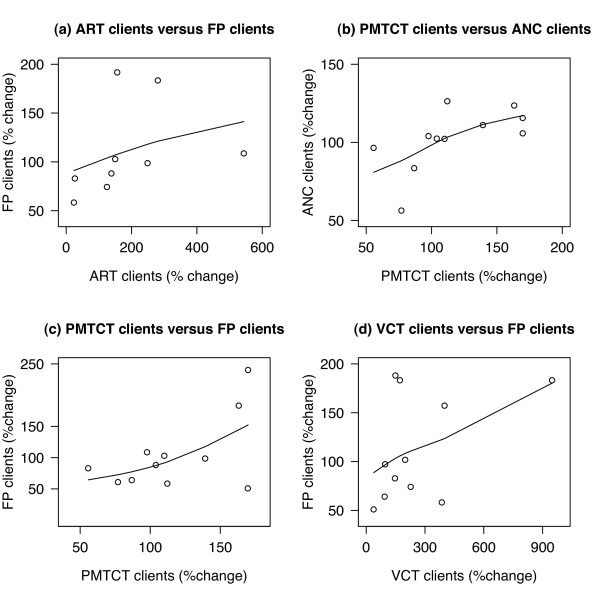
Correlations of changes in services, 2005-2007.